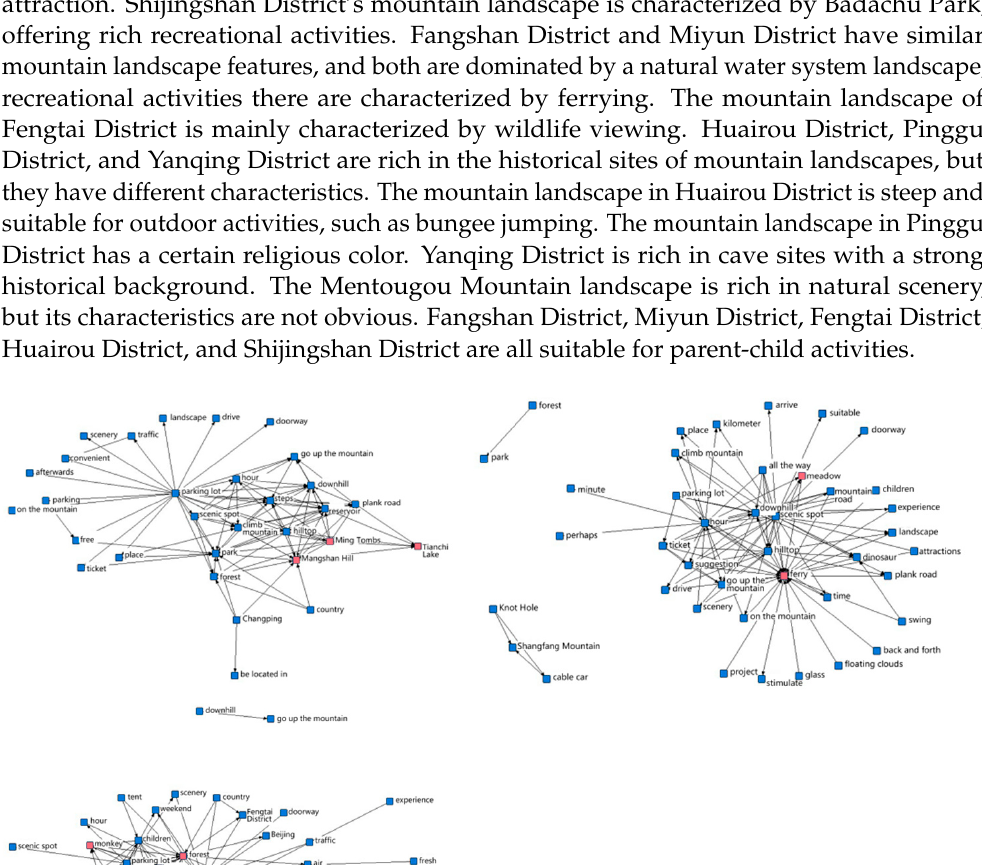
Figure 16. The semantic network for the Yan Mountain landscape.